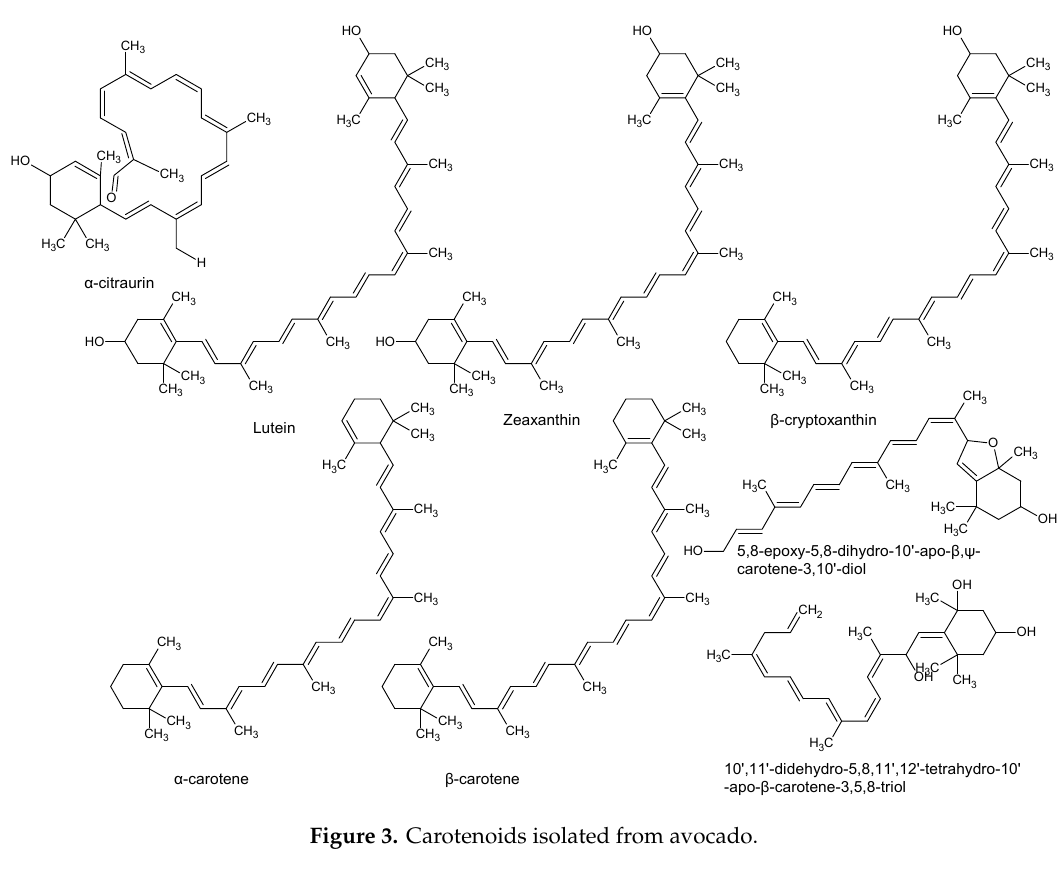
Figure 3. Carotenoids isolated from avocado.